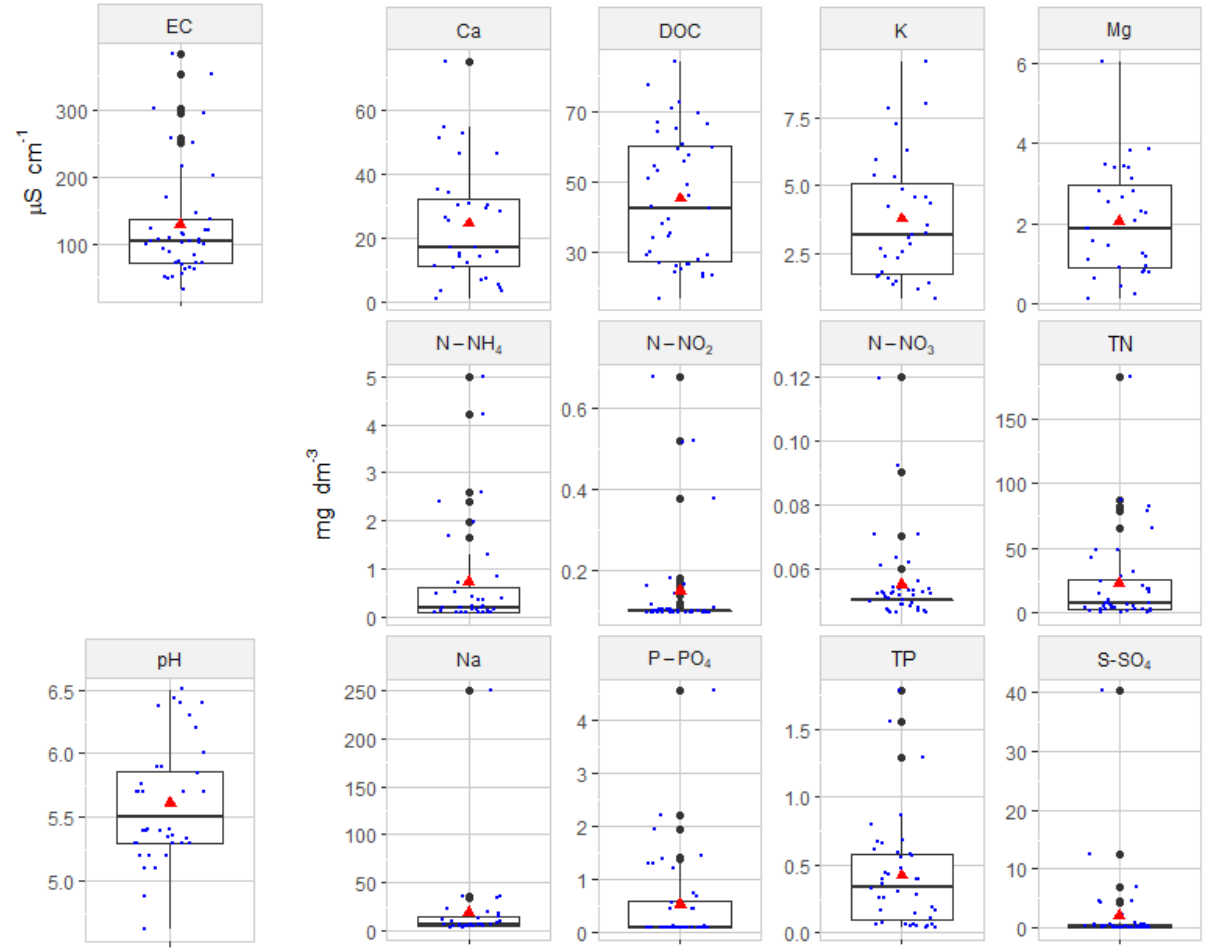
Figure 2. Distributions of values of the investigated physicochemical properties of piezometric groundwater at the sampling sites in 2011–2013. The small blue dots represent values observed on individual sampling dates at Lake Bikcze (B), Lake Karaśne (K), Lake Długie (D), Lake Moszne (M), the mid-forest bog Blizionki (BZ) and the Dekowina (DK) wetland sanctuary. In each boxplot, the box represents the first and third quartiles and the horizontal line dividing the box represents the median. The mean is indicated by the filled red triangle. The whiskers extend to the most extreme observations that are located no more than 1.5 times the interquartile range away from the box. Any observation not included between the whiskers is considered an outlier and is represented by a black dot along the whisker-axis. When there are no outliers, the whiskers terminate at the minimum and maximum